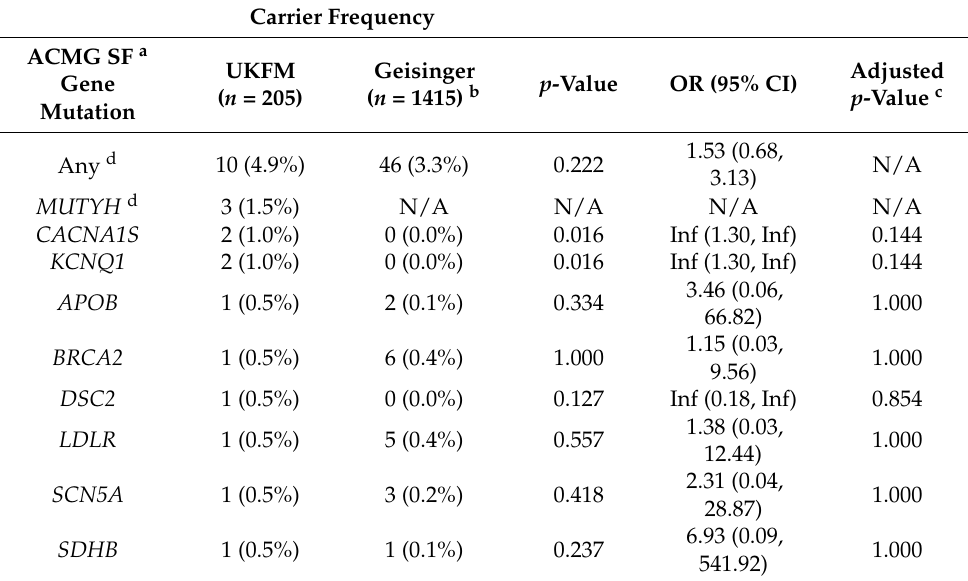
Table A4. Observed ACMG SF gene mutation carrier frequencies between the present and other population screening